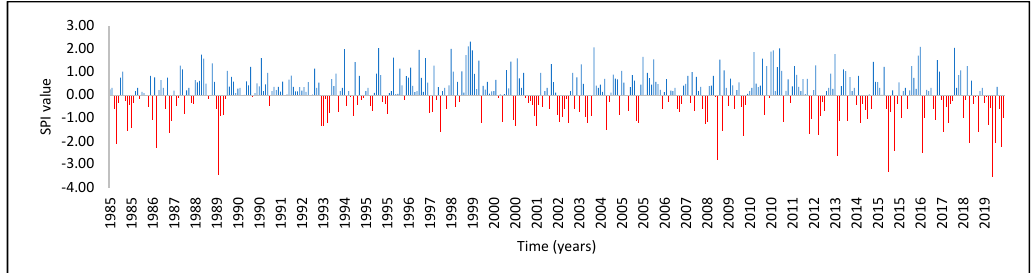
Figure 5. SPI time series, Argentina Hda station in the period (1985–2019).